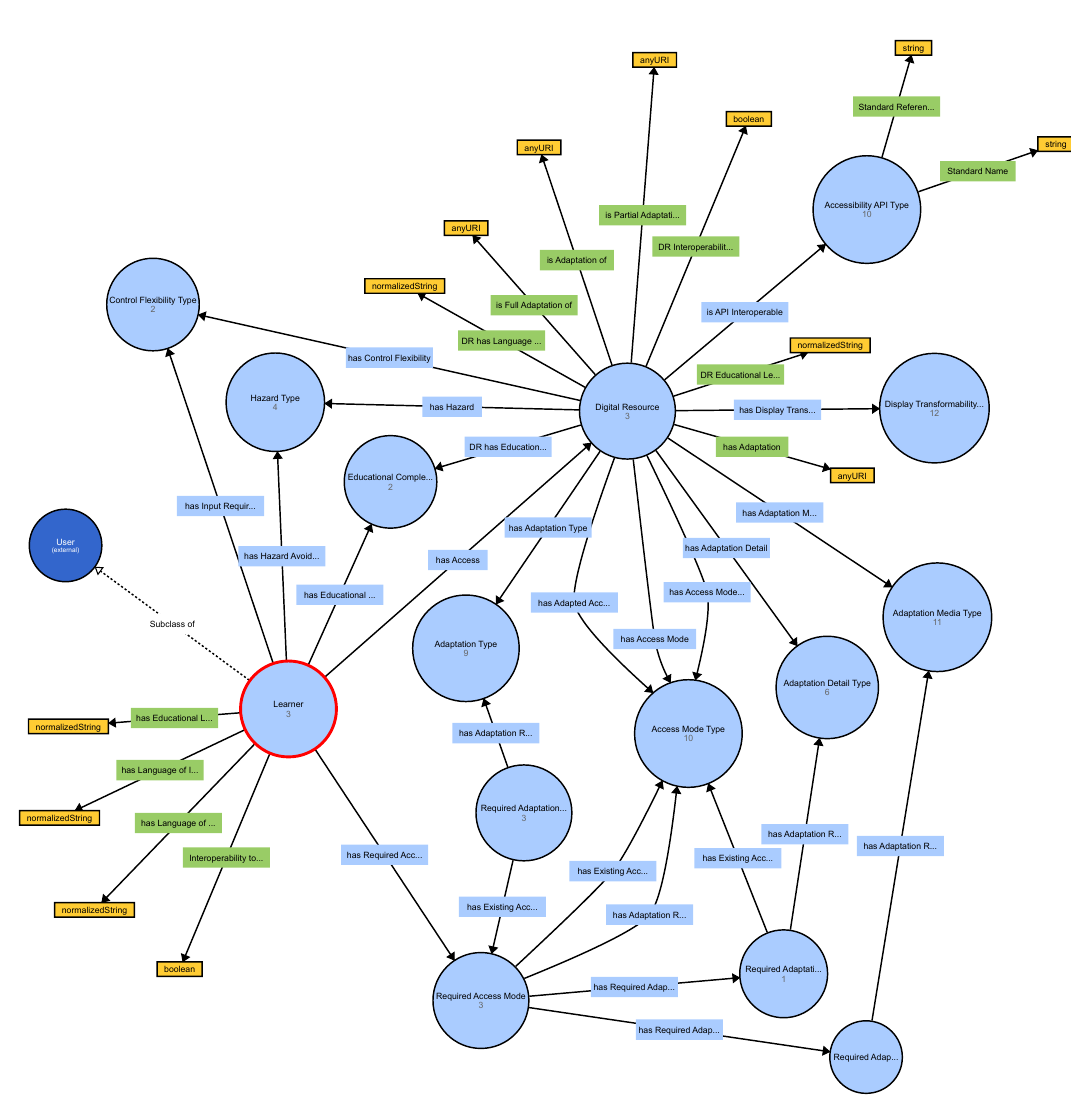
Figure A1. Visual representation of our AccessibleOCW ontology, created with the tool WebVOWL